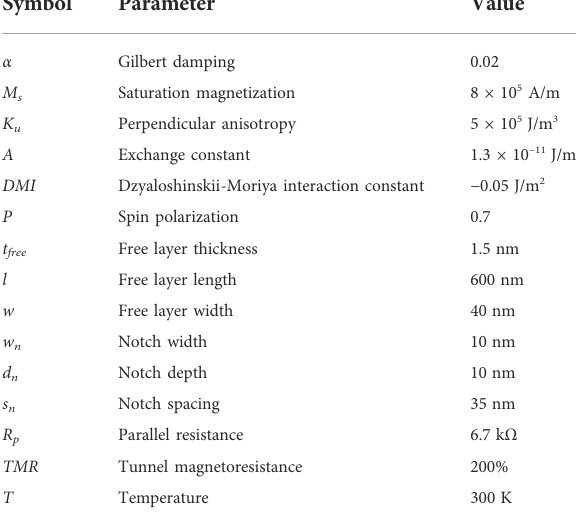
TABLE1PhysicalparametersusedinthemacrospinLLGsimulationsof the Bayes-MTJ. Symbol